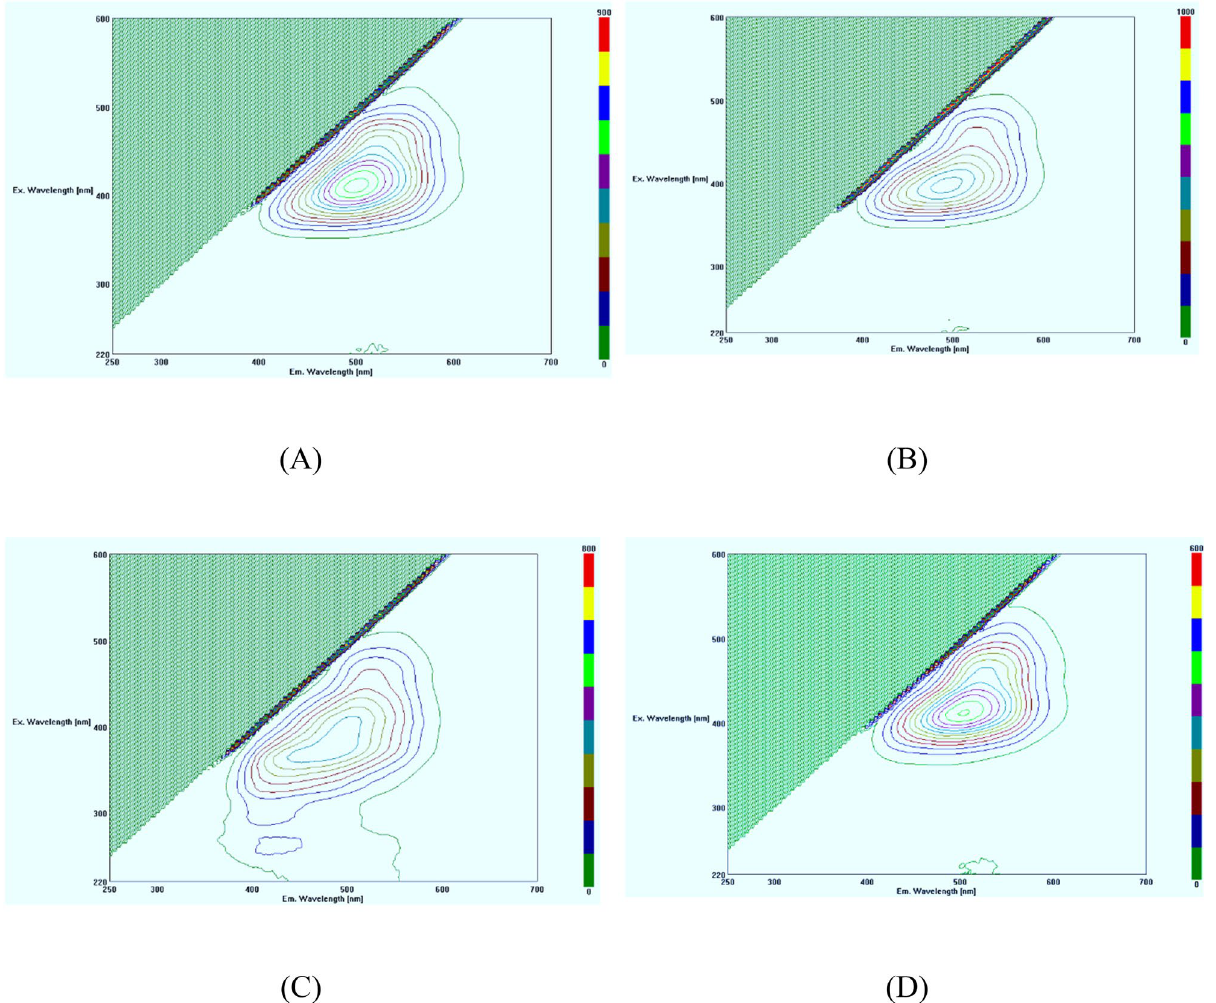
Figure 6. Fluorescence excitation-emission matrix (FEEM) spectra of humic acid-like and fulvic- like substances in liquid digestate from different pre-treatment with enzymatic hydrolysis. ( A ) is with sole enzymatic hydrolysis, ( B ) is acid pre-treatment followed by enzymatic hydrolysis, ( C ) is alkaline pre-treatment followed by enzymatic hydrolysis, ( D ) is boiled hot water pre-treatment followed by enzymatic